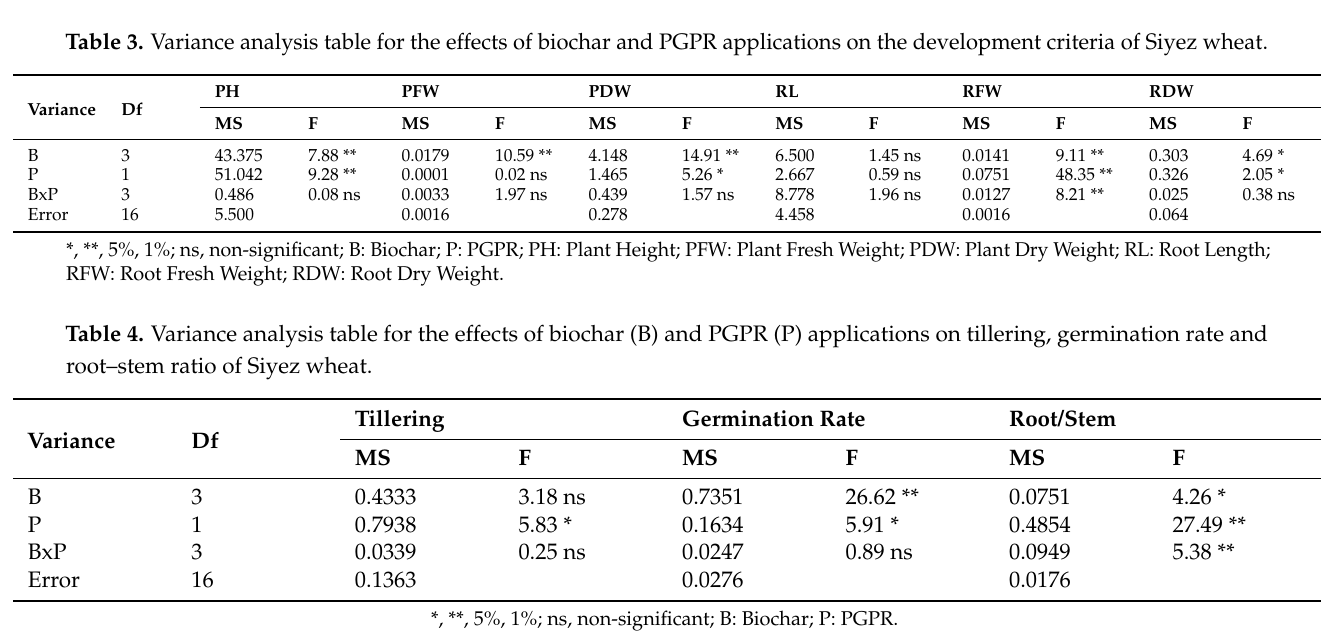
Table 5. Variance analysis table for the effects of biochar (B) and PGPR (P) applications on phosphorus (P), potassium (K), calcium (Ca), magnesium (Mg), and sodium (Na) nutrient contents of Siyez wheat.